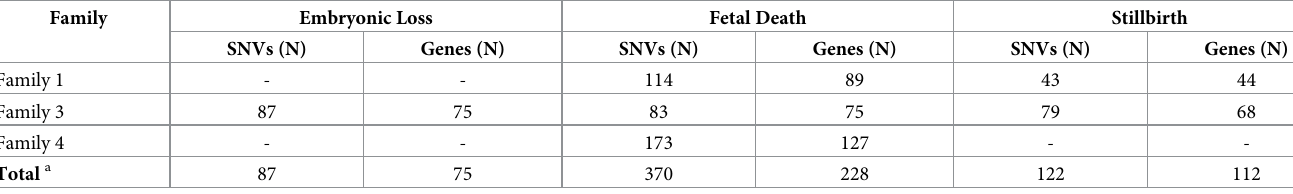
Table 2. Number of SNVs (and genes) in